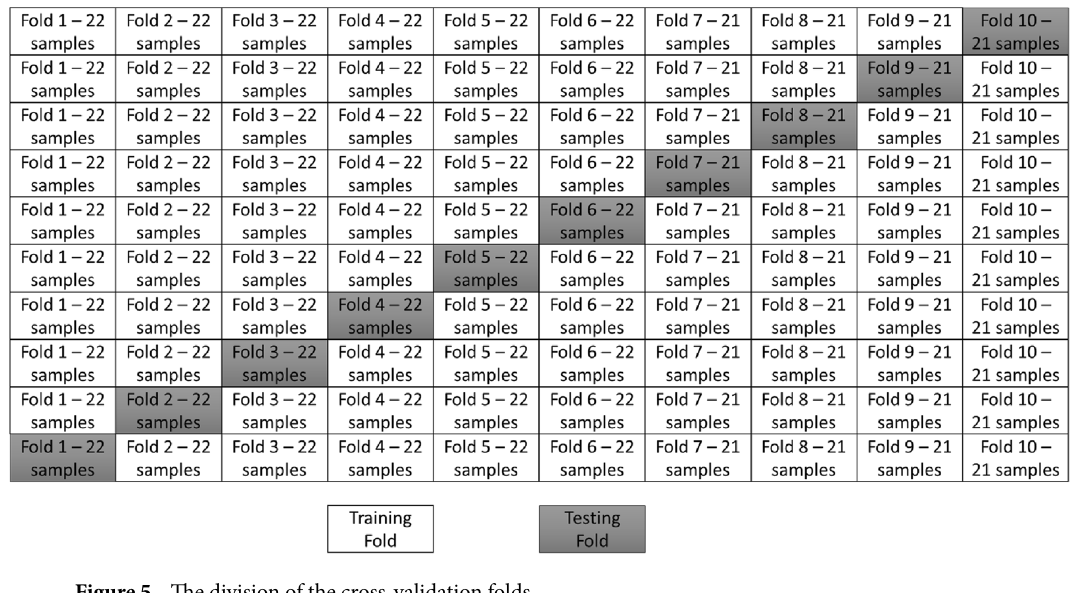
Figure 5. The division of the cross-validation folds.